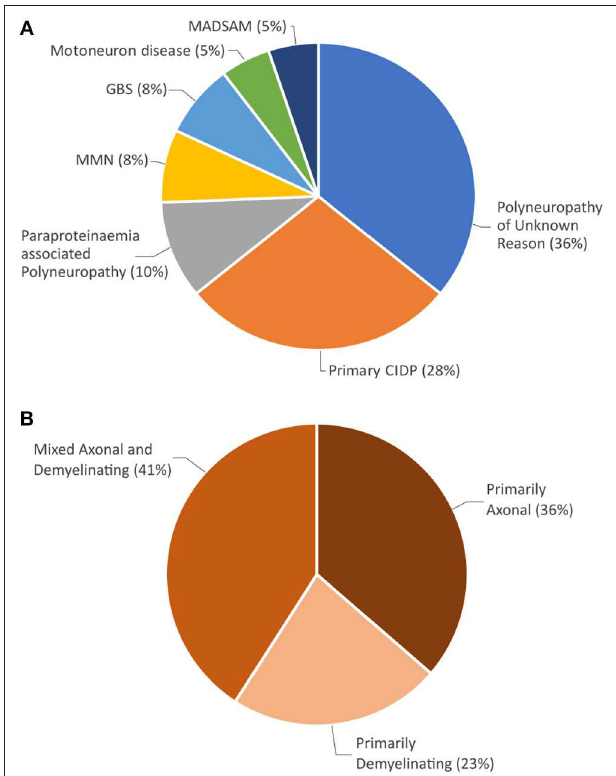
FIGURE 2 | (A) Neuropathy diagnoses prior to Sjögren’s syndrome diagnosis. (B) Distribution of electrophysiological damage pattern at initial neurographic analysis.